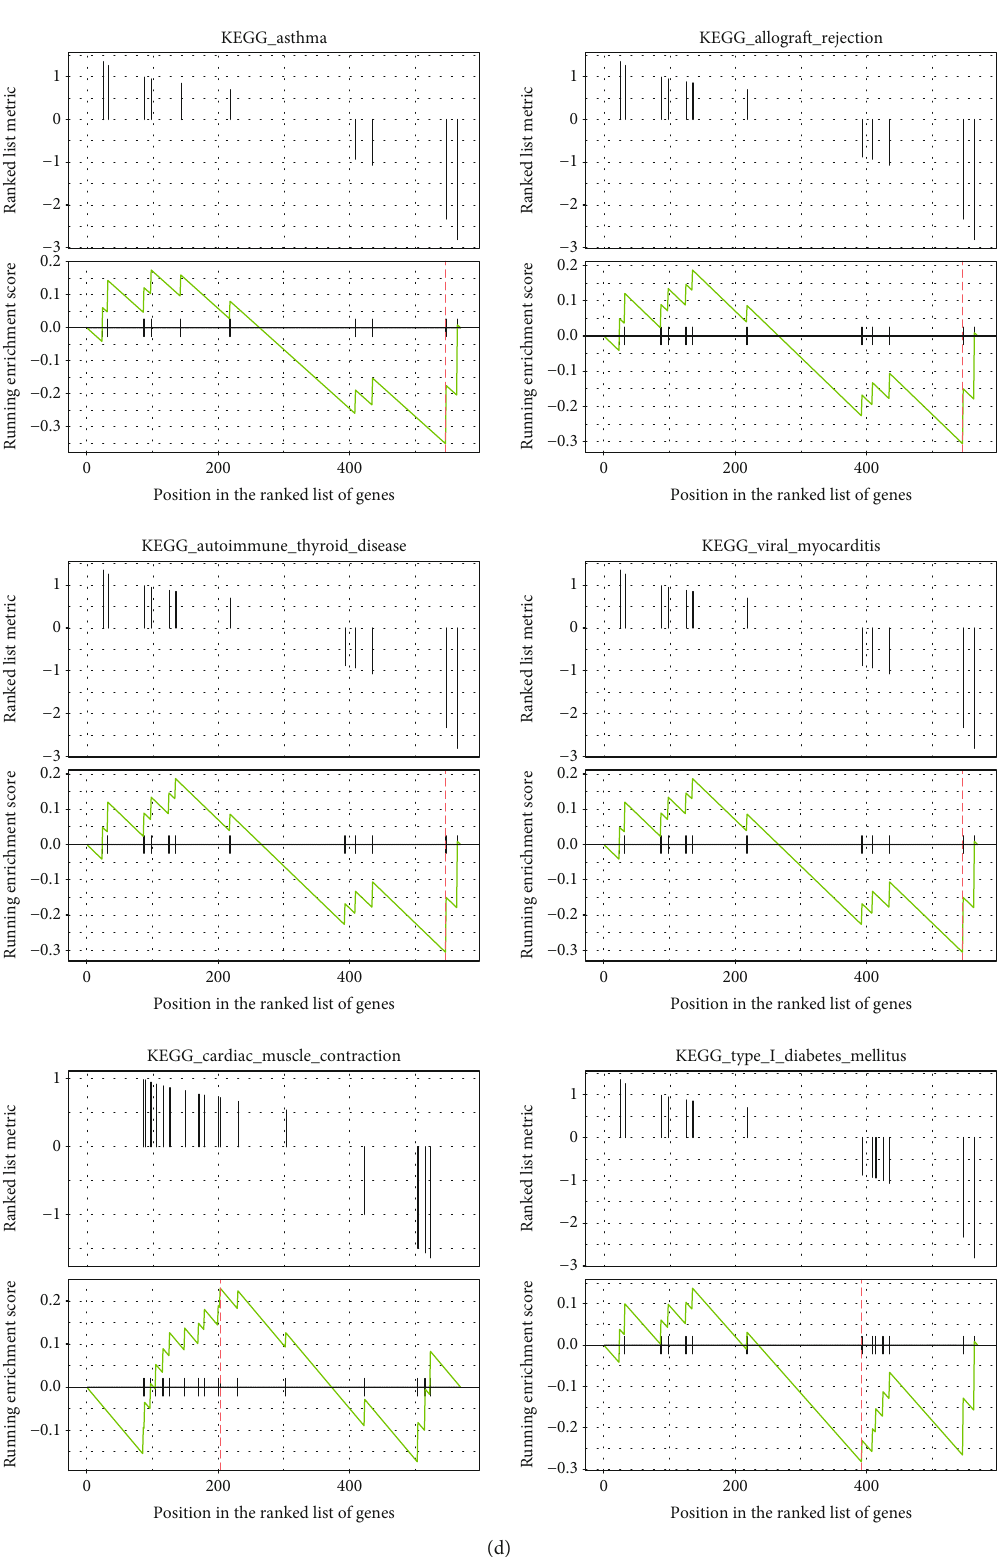
Figure 3: Gene enrichment analysis of the DEGs in the myeloid subsets. (a) Volcano plot demonstrated the statistical signi fi cance ( P value) versus the magnitude of change (fold change) of the DEGs (1 vs. 6). (b) Violin plots showed the percentage and intensity of gene expression by clusters 1 and 6. (c) CNET plots indicated the network of DEGs in clusters 1 and 6. (d) GSEA identi fi ed the upregulated or downregulated DEGs in the indicated signaling